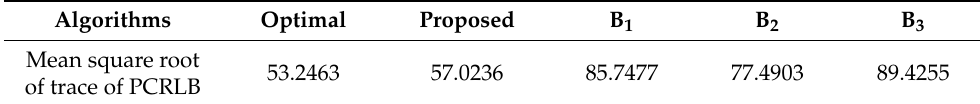
Table 6. Comparison of the performance when | α k | 2 / σ v 2 = 1 / 100.